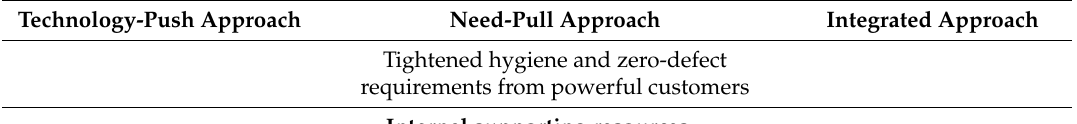
Table 9. Summary of the adoption drivers for Kornelis Caps and